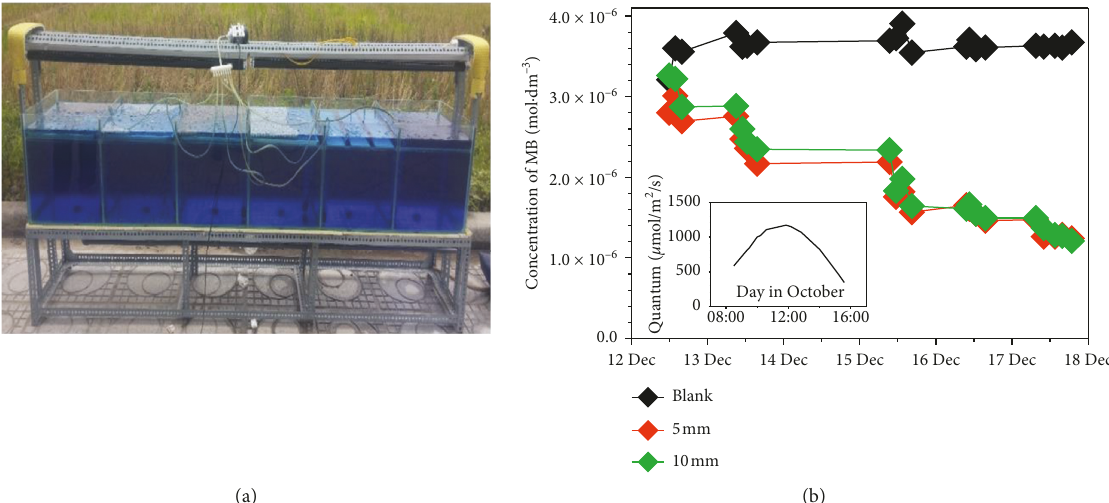
Figure 13: Pilot experiments in Vietnam. (a) Set of solar reactors with floating photocatalyst. (b) Photocatalytic degradation of MB during 6days of solar